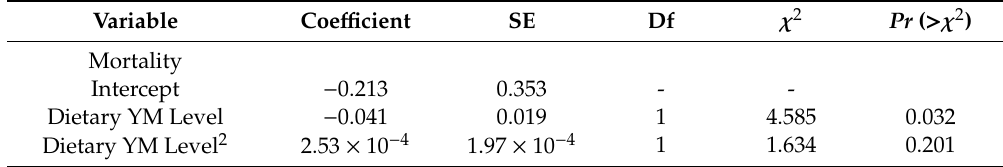
Figure 1. Cumulative mortality as a function of ŸnMeal TM (YM) dietary level on Day 10 after immune challenge with Vibrio parahaemolyticus (n = 30). Table 4. Mortality as a function of dietary insect meal (YM) levels.